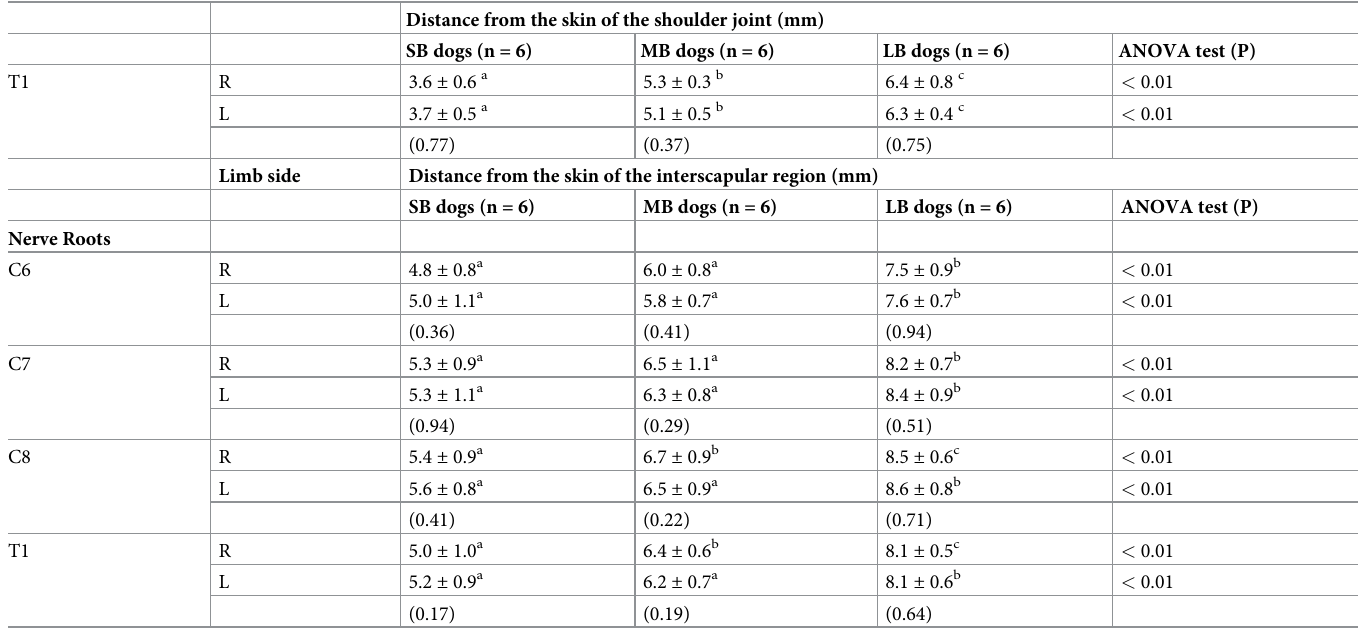
Table 3. Distance of the nerve roots of the spinal nerves from the